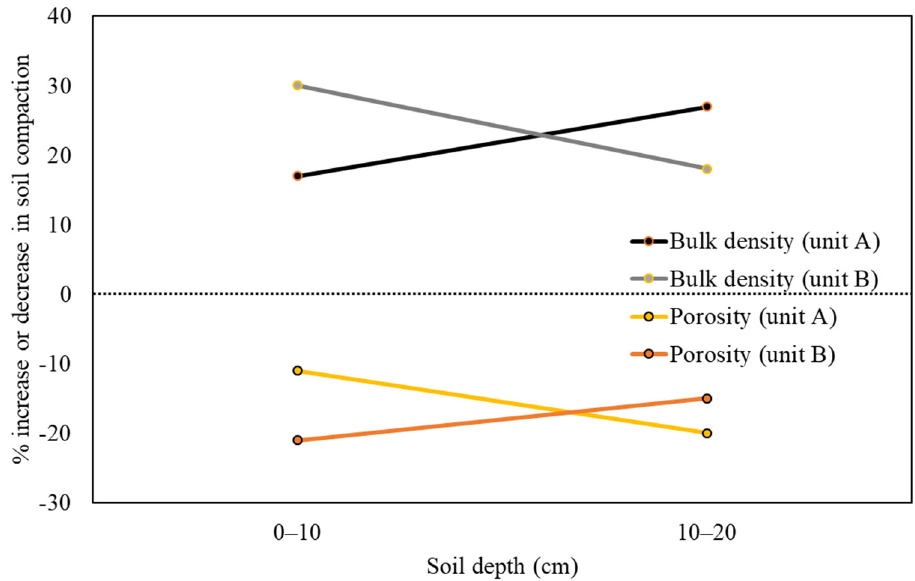
Figure 3. Percentage increase in bulk density and decrease in porosity on the track after harvester passing at 0–10 cm and 10–20 cm soil depths at unit A and unit B.